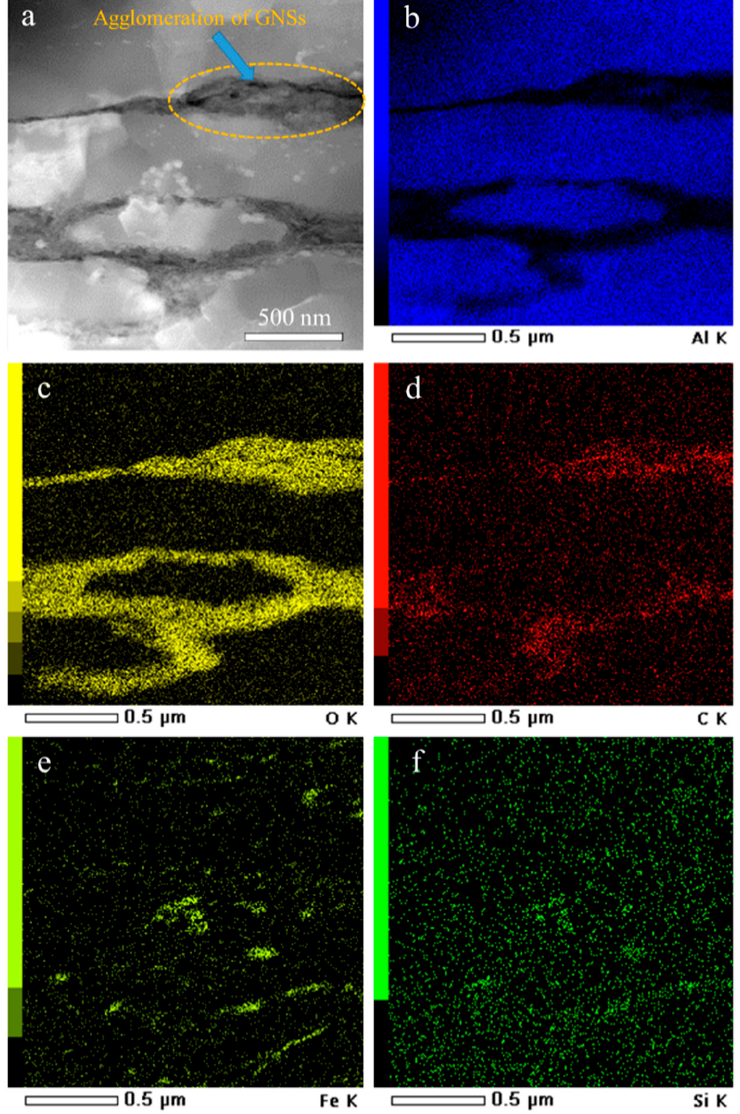
Figure 7. ( a ) Transmission electron microscopic image of Al-1 wt.% GNS and its element distribution map of ( b ) Al; ( c ) O; ( d ) C; ( e ) Fe; and ( f ) Si.